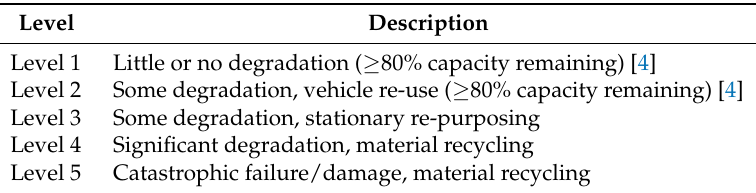
Table 8. Re-purposed battery pack